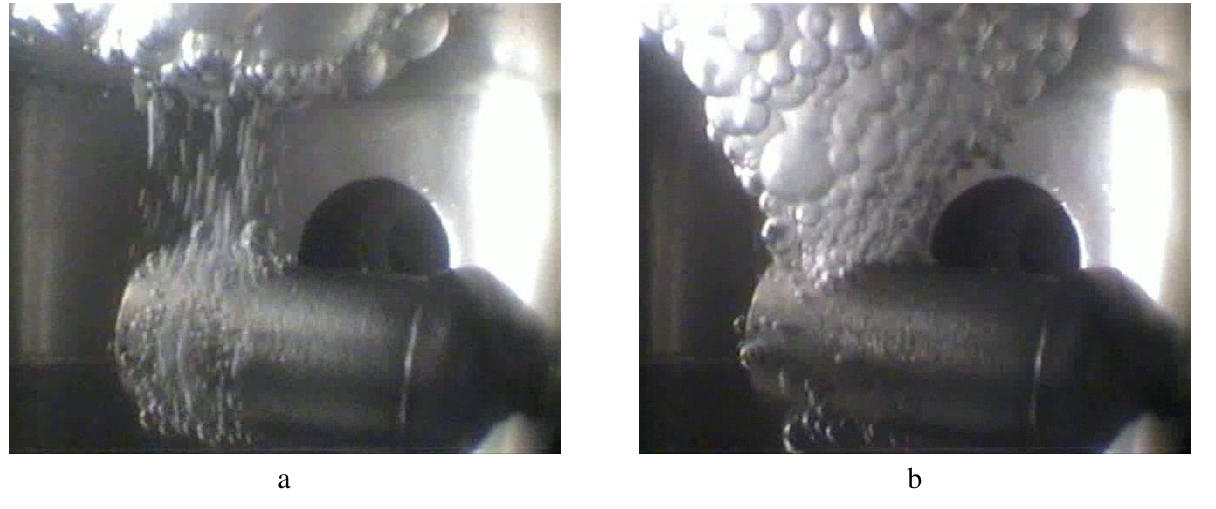
Figure 9. (a) Methane injection through a sintered filter into water; (b) methane injection through a sintered filter into